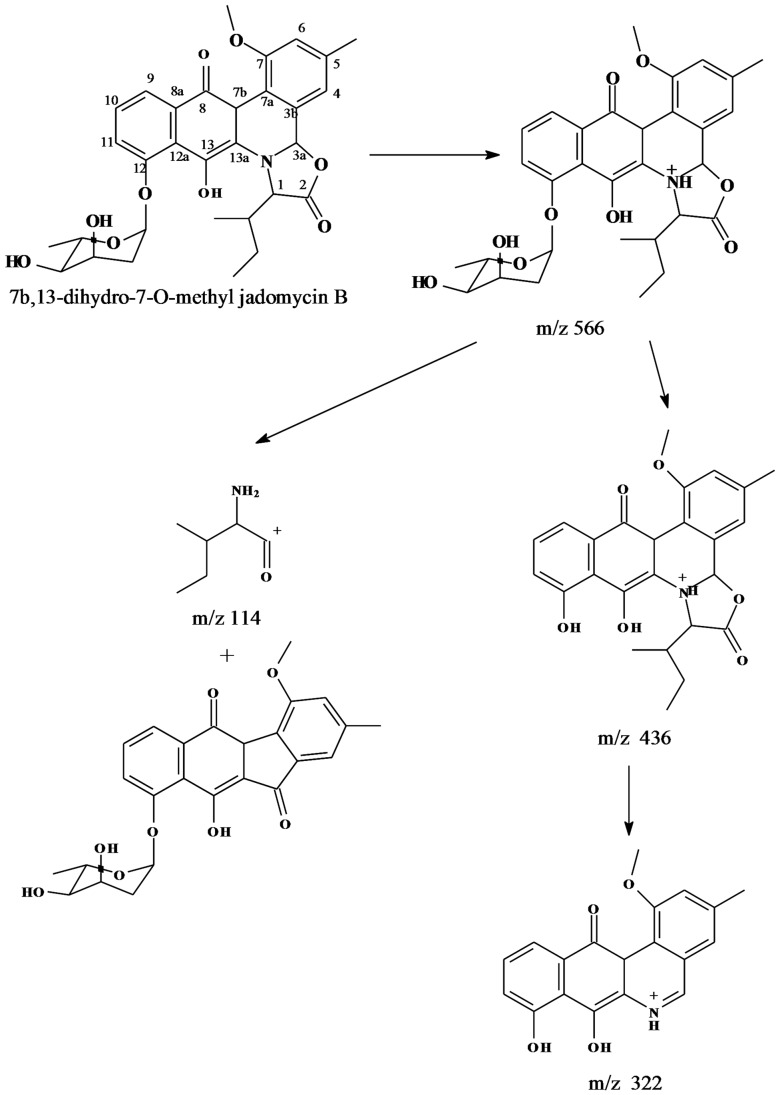
Suggested fragmentation process of selected ion at tR 4.18 min in TIC.